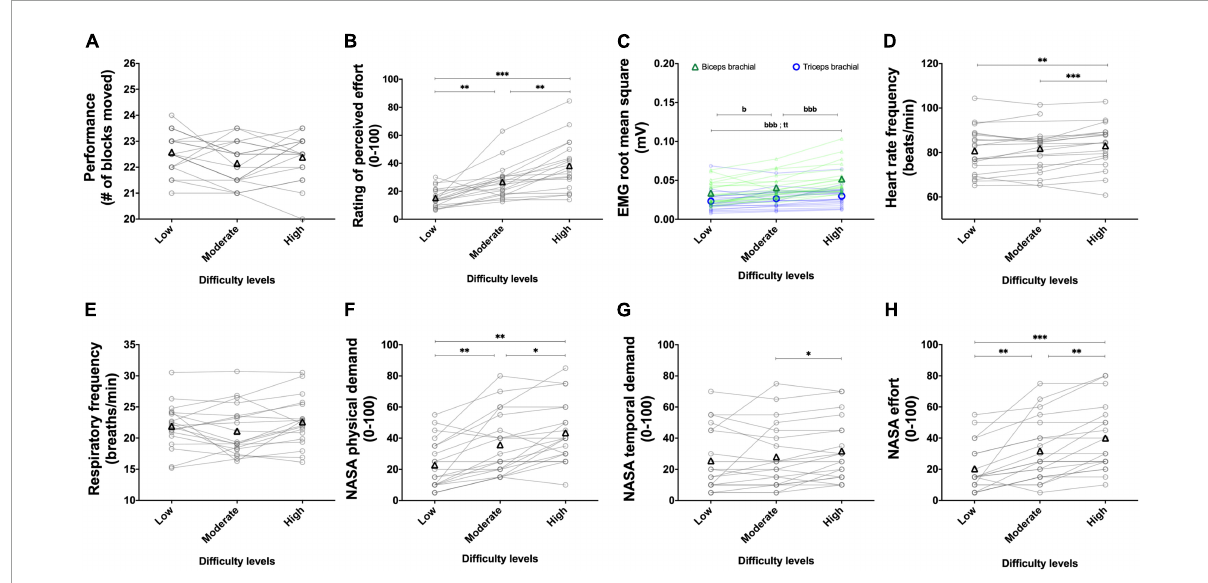
FIGURE7 Experiment 1B: Adding weight on the forearm to alter task difficulty during the box and block test. The effect of manipulating the weight during the box and block test on performance ( A , n = 20), rating of perceived effort ( B , n = 20), EMG root mean square of the biceps (green line) and triceps (blue line) brachial muscles ( C , n = 20), heart rate frequency ( D , n = 16), respiratory frequency ( E , n = 20) and NASA TLX scores for the physical demand ( F , n = 20), the temporal demand ( G , n = 20), and the subjective effort ( H , n = 20). Movements were performed at a fixed tempo of 0.75 Hz. For the low difficulty, no additional weight on the forearm was added. For the moderate difficulty, a weight of 0.5 kg was added. For the high difficulty, a weight of 1 kg was added. Data are presented as the main effect of difficulty, except for panel (C) presenting the difficulty × muscle interaction. The n indicates the number of participants with all the data in each of the three levels of difficulties. Changes in the n reflect data loss due to issues with equipment or movement artifact. Individual data are presented in light markers and means in dark markers. *Main effect of difficulty, the difference between two difficulty levels. b and t difference between two difficulty levels for the biceps and triceps brachial muscles, respectively. One symbol: p < 0.05, two symbols: p < 0.01, and three symbols: p <